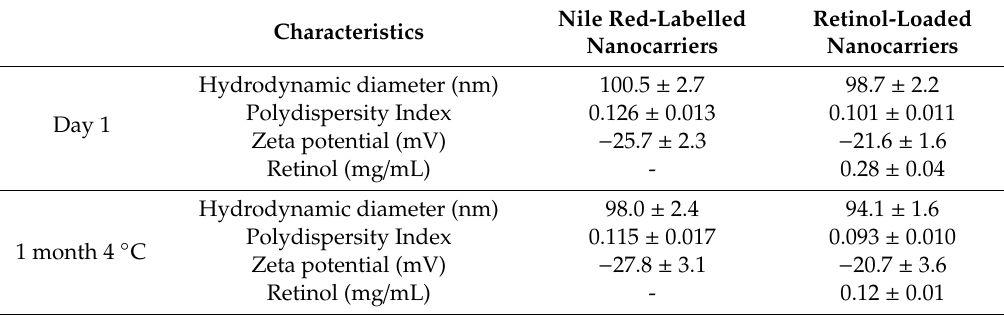
Table 1. Characteristics of nanocarriers (mean values ± SD, n =